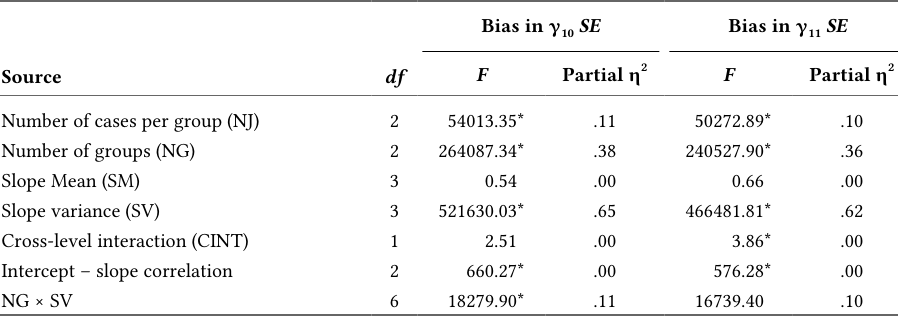
Bias in γ SE Bias in γ SE 10 11 F Partial η 2 F Partial η 2